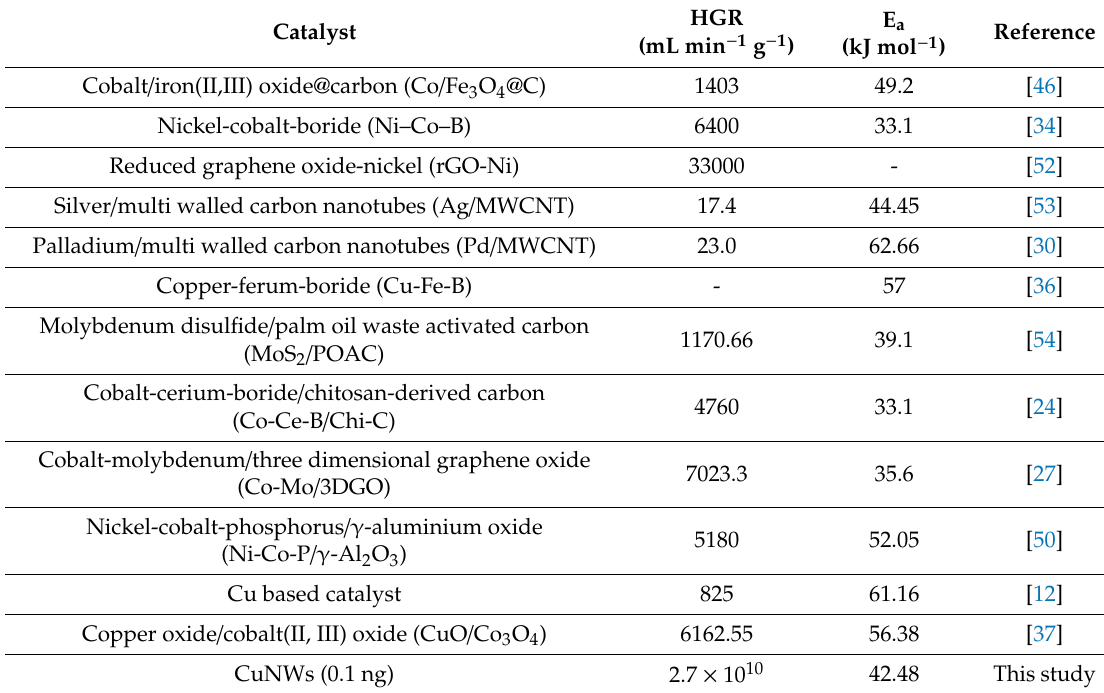
Figure 4. Plot of ( a ) di ff erent reaction temperatures on H 2 generation versus time; and ( b ) the Arrhenius plot, ln k versus 1 / T. (Conditions: CuNWs = 0.1 ng, 10 mL of [NaBH 4 ] = 1 wt%, and pH = 12). Table 3. List of comparisons of catalytic performance in this study with those reported in previous